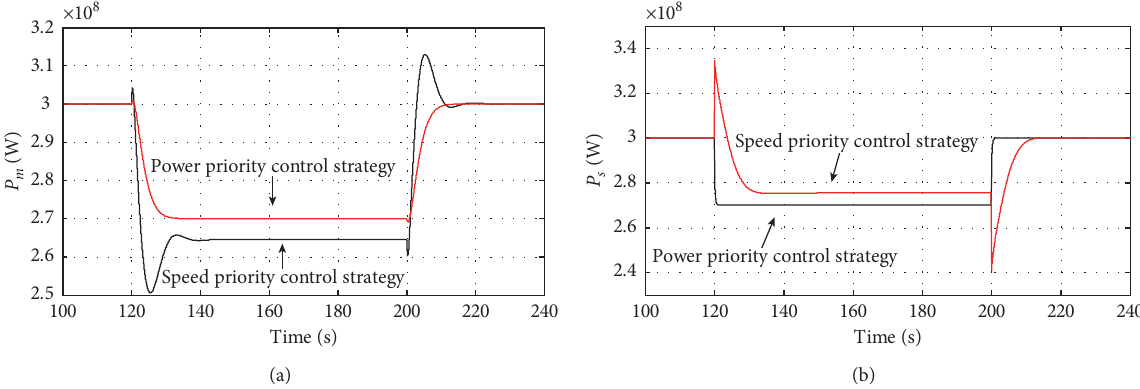
Figure 36: Active power comparison diagram when P power. (b) Comparison diagram of stator-side active power.